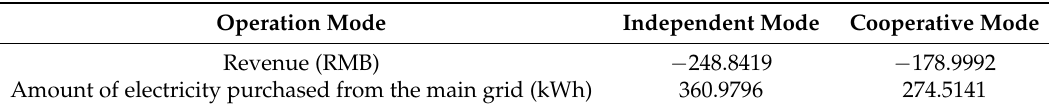
Table 4. Comparison of revenue between the two operation modes.